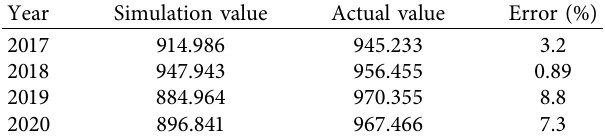
Table 2: Effectiveness test results.